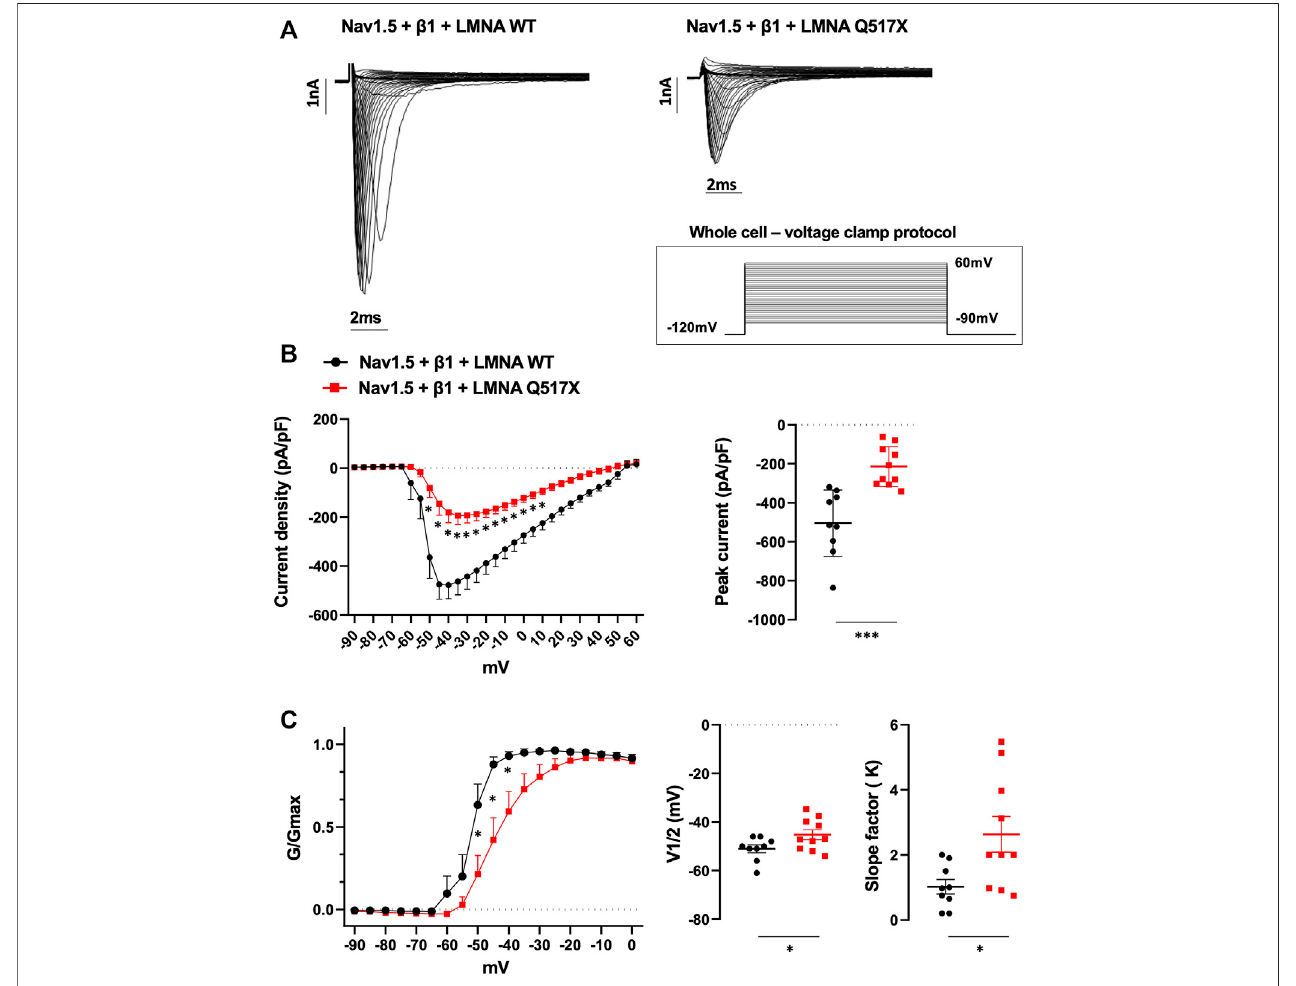
FIGURE 5 | (A) Representative traces of inward Na + currents evoked in HEK293 cells expressing either LMNA WT or LMNA Q517X, under 20s depolarizing steps from − 90mV to +60 mV (with 5-mV increments) starting from an holding potential of − 120 mV. (B) Left panel: current density (pA/pF) – voltage relationships (I – V curve) of the Na + currents recorded for LMNA WT (black trace, N = 9), and LMNA Q517X-expressing HEK293 cells (red trace, N = 10); p < 0,0001 from − 50 mV to − 20 mV; p -value < 0.001 at F02D15 mV an − 10 mV; p -value < 0,01 at − 5 mV and p -value < 0,05 at 0 mV and 5 mV, two-way Anova. Right panel: scatter plot of the maximumpeaksodiumcurrents(pA/pF) forLMNAWT(blackdots)andLMNAQ517X-expressingHEK293cells(redsquares);*** p < 0.001,Student ’ s t testforunpaired data). (C) Leftpanel: conductance voltage (G/Gmax) relationshipsofNa + currents (G – Vcurve)obtainedforLMNA WT(black trace,N=9)and LMNAQ517X-expressing HEK293 cells (red trace, N = 10); p -value < 0,0001 at − 50 mV and − 45 mV; < 0.001 at − 40 mV, two-way Anova. Right panel: scatter plots of the half-maximal conductance (V1 ⁄ 2) and the slope factors (K) in LMNA WT (black dots) or LMNA Q517X-expressing HEK293 cells (red squares), respectively; * p < 0.01 Student ’ s t test for unpaired